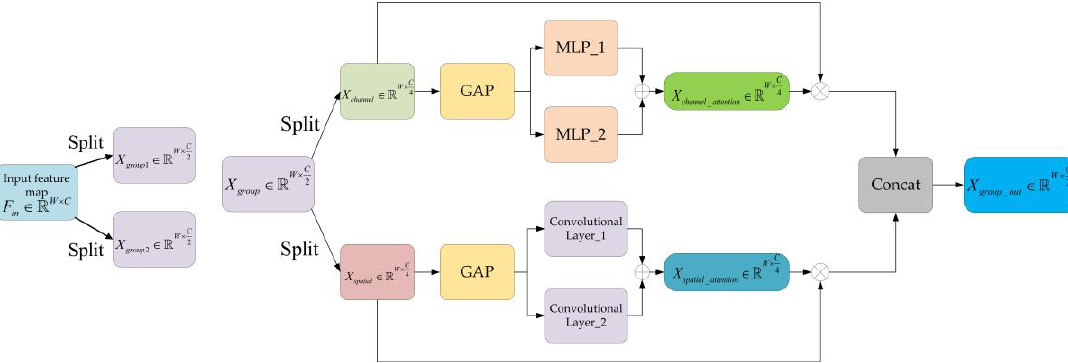
Figure 3. The structure of mixed attention